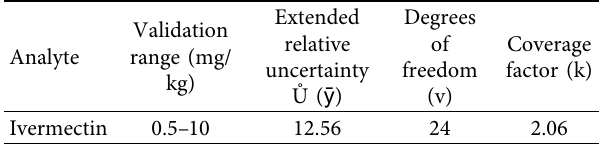
Table 2: Data elaboration for each concentration level. Concentration level (mg/kg)